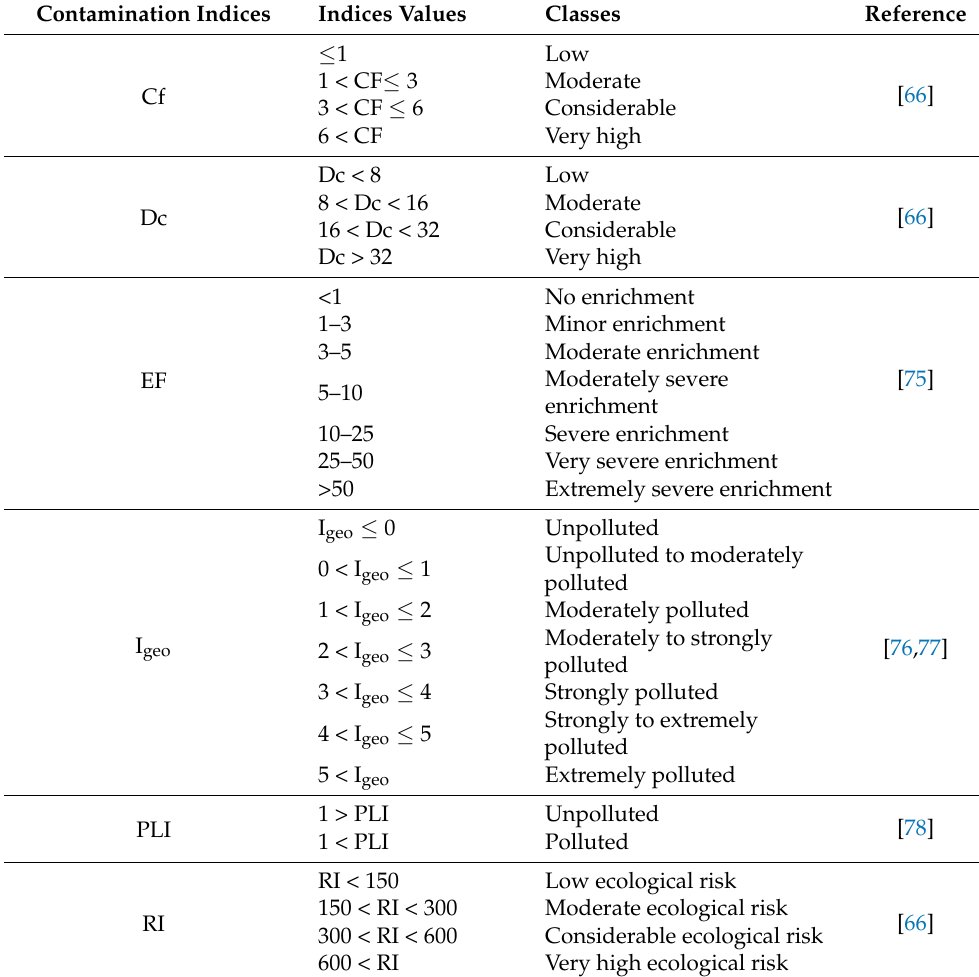
Table 1. Classes of contamination factor (Cf), degree of contamination (Dc), enrichment factor (EF), geo-accumulation index (I geo ), pollution load index (PLI), and potential ecological risk index